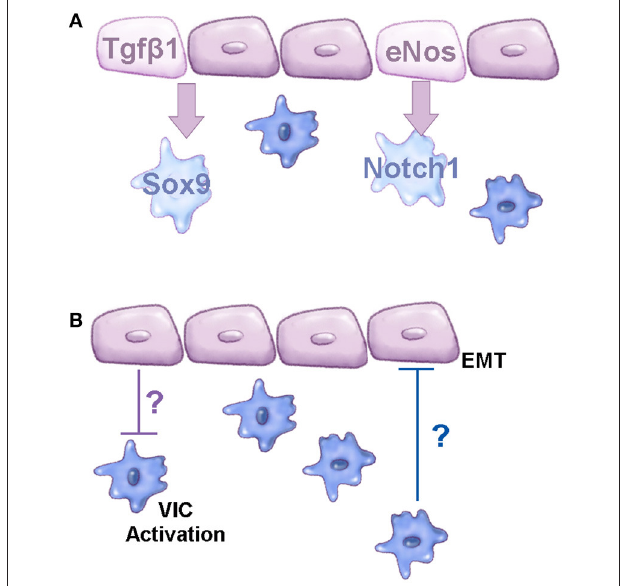
FIGURE 2 | Molecular communications between VEC and VIC populations. (A) Schematic to show known signaling pathways active between VEC and VIC populations that prevent CAVD. (B) Diagram to demonstrate known cellular functions regulated by VEC-VIC communications; the mechanisms underlying these functions are currently unknown, based on studies by Hjortnaes et al. ( 140). Purple cells represent valve endothelial cells, blue cells are valve interstitial